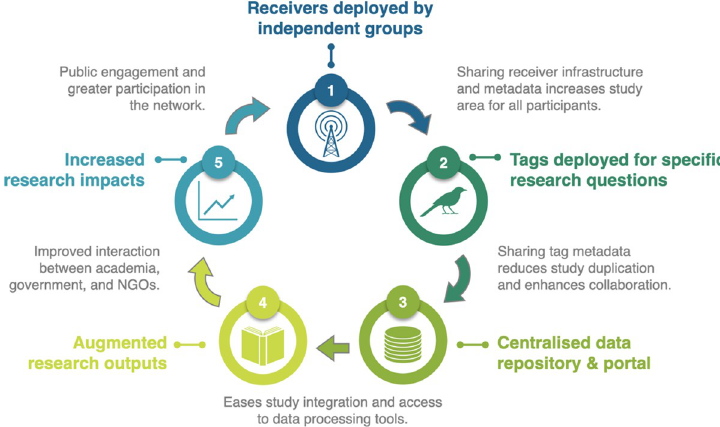
Fig 5. Schematic representation of the components and benefits of node-based collaborative research infrastructure for detecting and tracking the movements of animals.